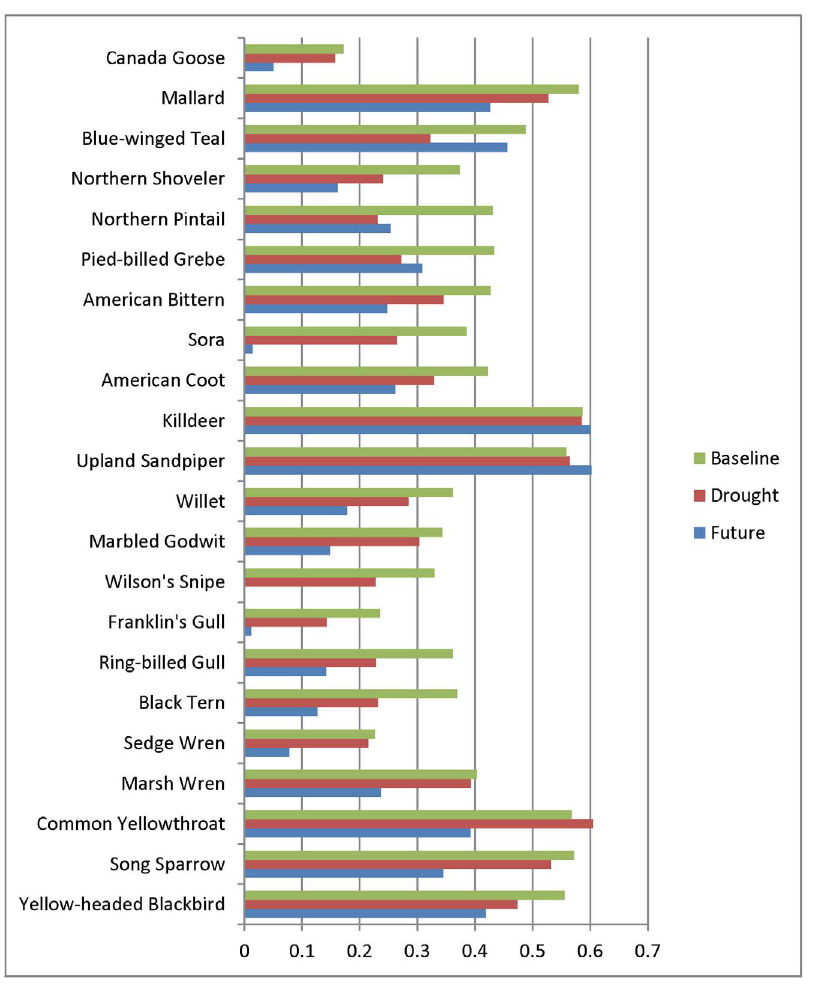
Figure 4. Mean rates of predicted species occurrence at 4,957 8-km grid points. Baseline rate was based on 1981–2000 climate records. Dry years showed predicted occurrence rates for the drought period, 1987–1992. Future rates were based on the average projections of two future climate datasets (CGCM-A2 and WRFc) for 2040–2049.